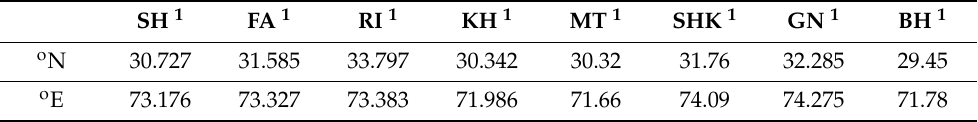
Table 2. Coordinates of cities, used to define their extent.